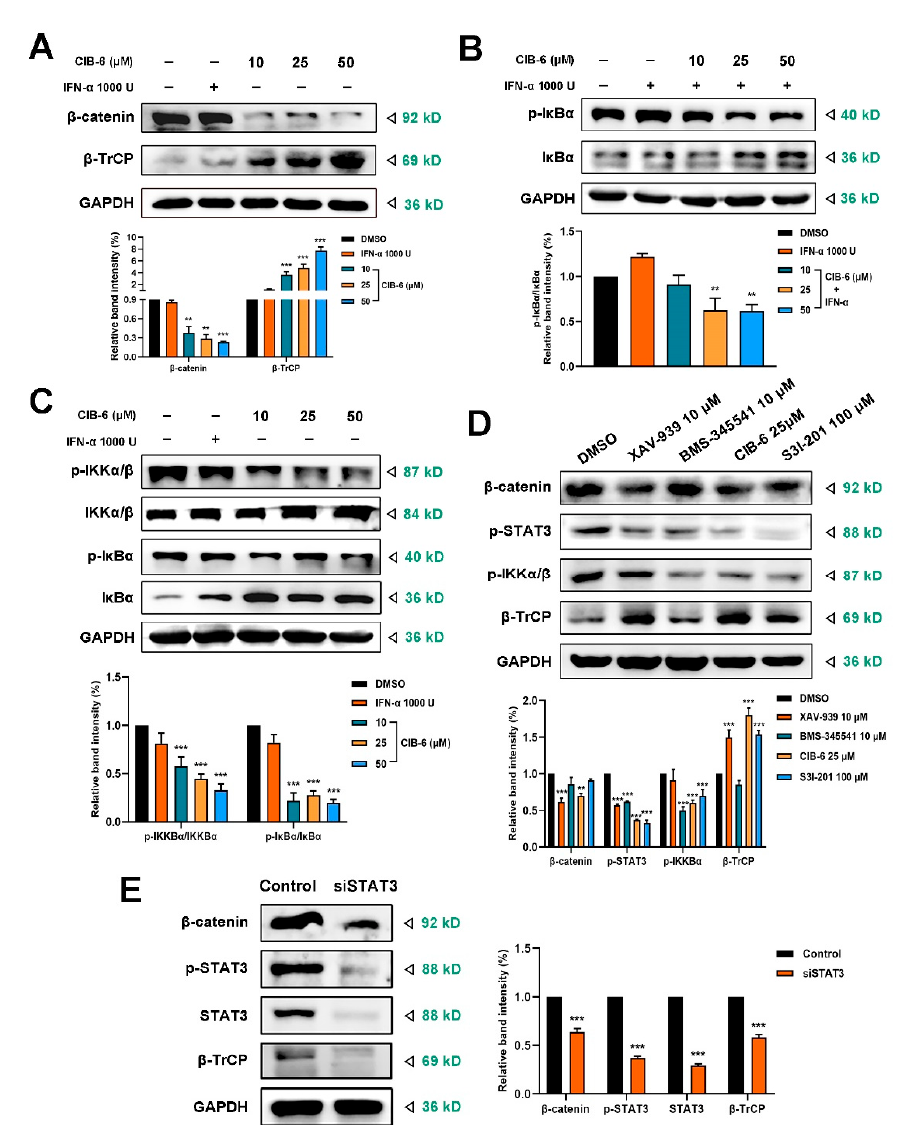
Figure 5. Effects of CIB-6 on the β -transducin repeat-containing protein ( β -TrCP)/ β -catenin/ nuclear factor kappa-B (NF- κ B) axis. ( A ) The SK-HEP-1 cells were treated with the indicated concentrations of CIB-6 for 24 h or stimulated with 1000 U/mL IFN- α for 0.5 h. Cell lysates were immunoblotted with antibodies against β -catenin and β -TrCP. Bar graph shows quantified levels of proteins from three independent experiments (** p < 0.01 and *** p < 0.001 as compared with DMSO). ( B , C ) The SK-HEP-1 cells were treated with the indicated concentrations of CIB-6 for 24 h or stimulated with or without 1000 U/mL IFN- α for 0.5 h. Cell lysates were immunoblotted with antibodies against total and phosphorylated proteins of I κ B α and IKK α / β . Bar graph shows quantified levels of p-IKK α / β /IKK α / β and p-I κ B α /I κ B α from three independent experiments (( B ), ** p < 0.01 as compared with IFN- α ; ( C ), *** p < 0.001 as compared with DMSO). ( D ) The SK-HEP-1 cells were treated with β -catenin inhibitor (XAV-939, 10 µ M, treat for 24 h), NF- κ B inhibitor (BMS-345541, 10 µ M, and treat for 2 h), CIB-6 (25 µ M, treat for 24 h) and STAT3 inhibitor (S3I-201, 100 µ M, treat for 24 h). The cell lysates were immunoblotted with antibodies against β -catenin, p-STAT3, p-IKK α / β , and β -TrCP. Bar graph shows quantified levels of proteins from three independent experiments (** p < 0.01 and *** p < 0.001 as compared with DMSO). ( E ) SK-HEP-1 cells were transiently transfected with siSTAT3. Thereafter, the cell lysates were immunoblotted with antibodies against β -catenin, β -TrCP, STAT3 and phosphorylated STAT3. Bar graph shows quantified levels of proteins from three independent experiments (*** p < 0.001 as compared with con- trol).